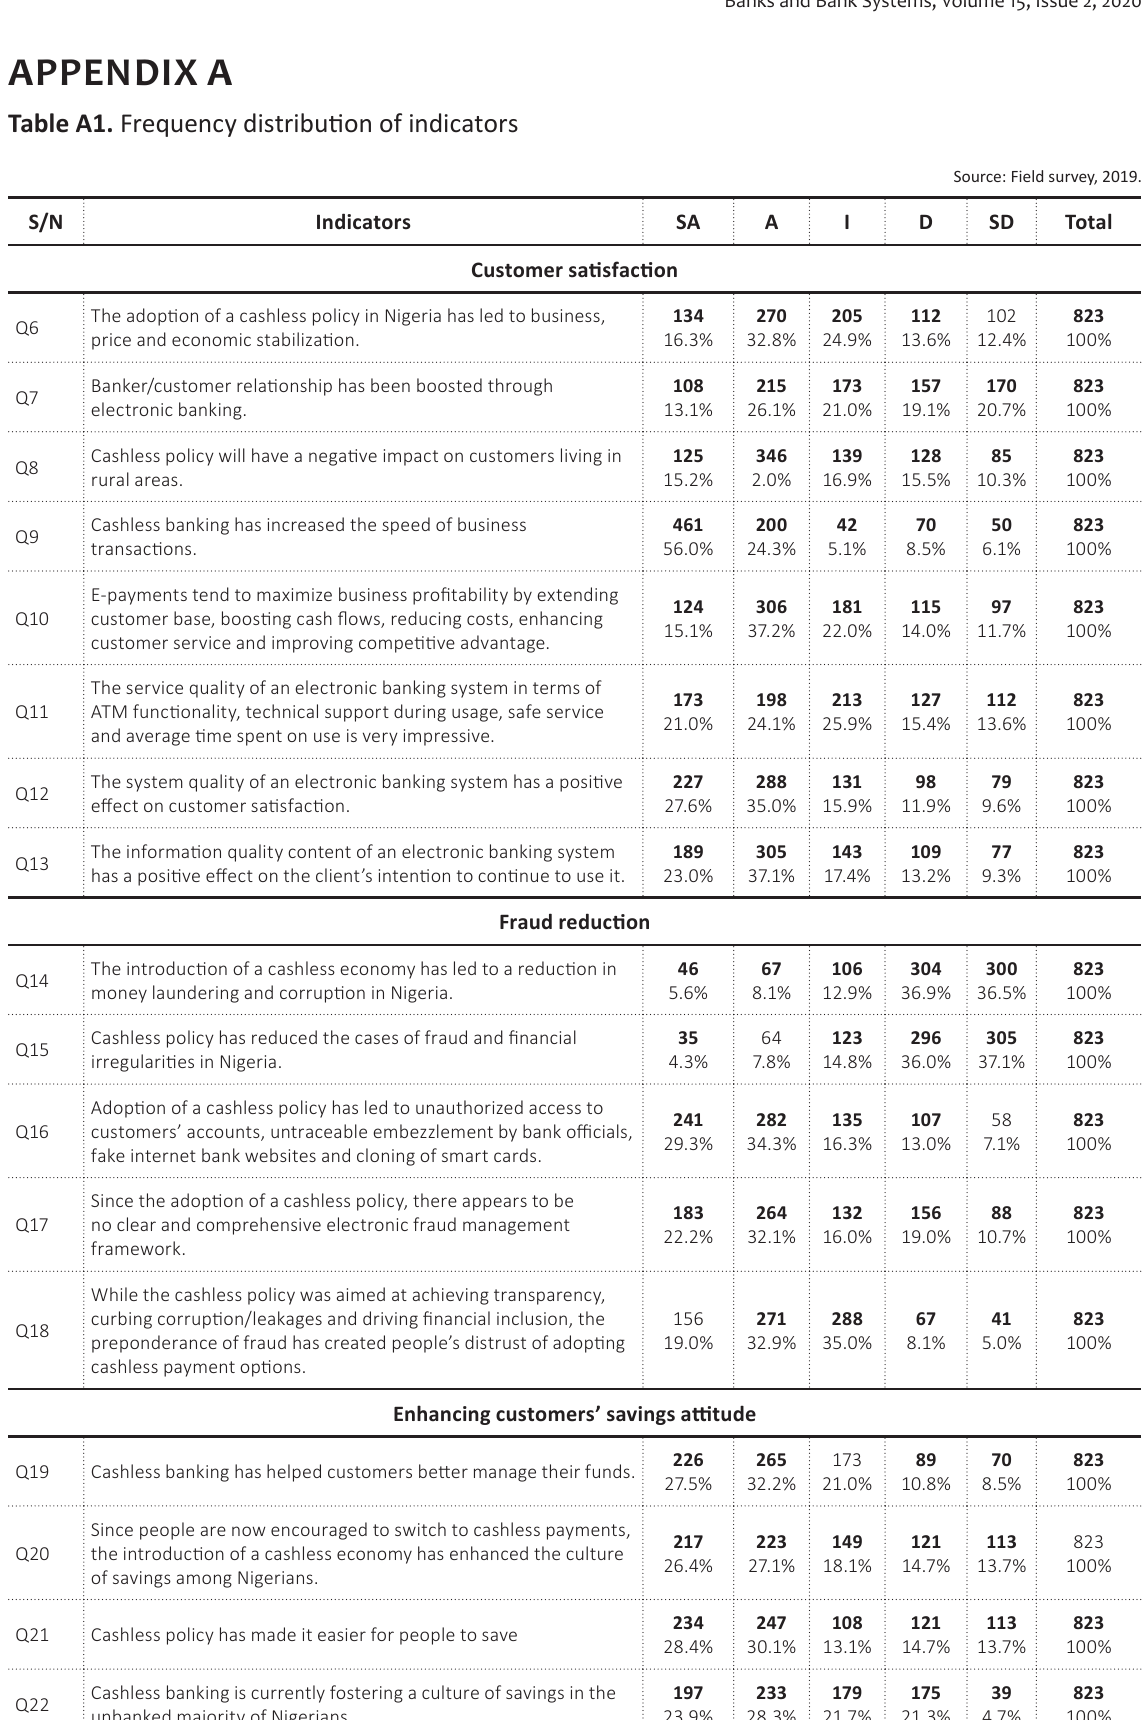
Table A1. Frequency distribution of indicators